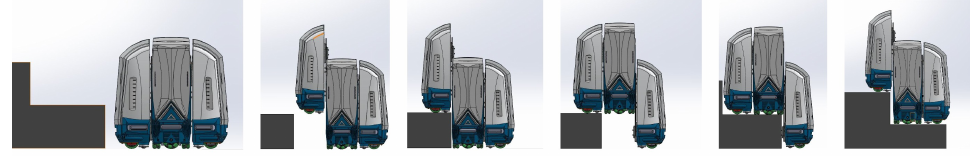
Figure 2. sTetro climbing mechanism.